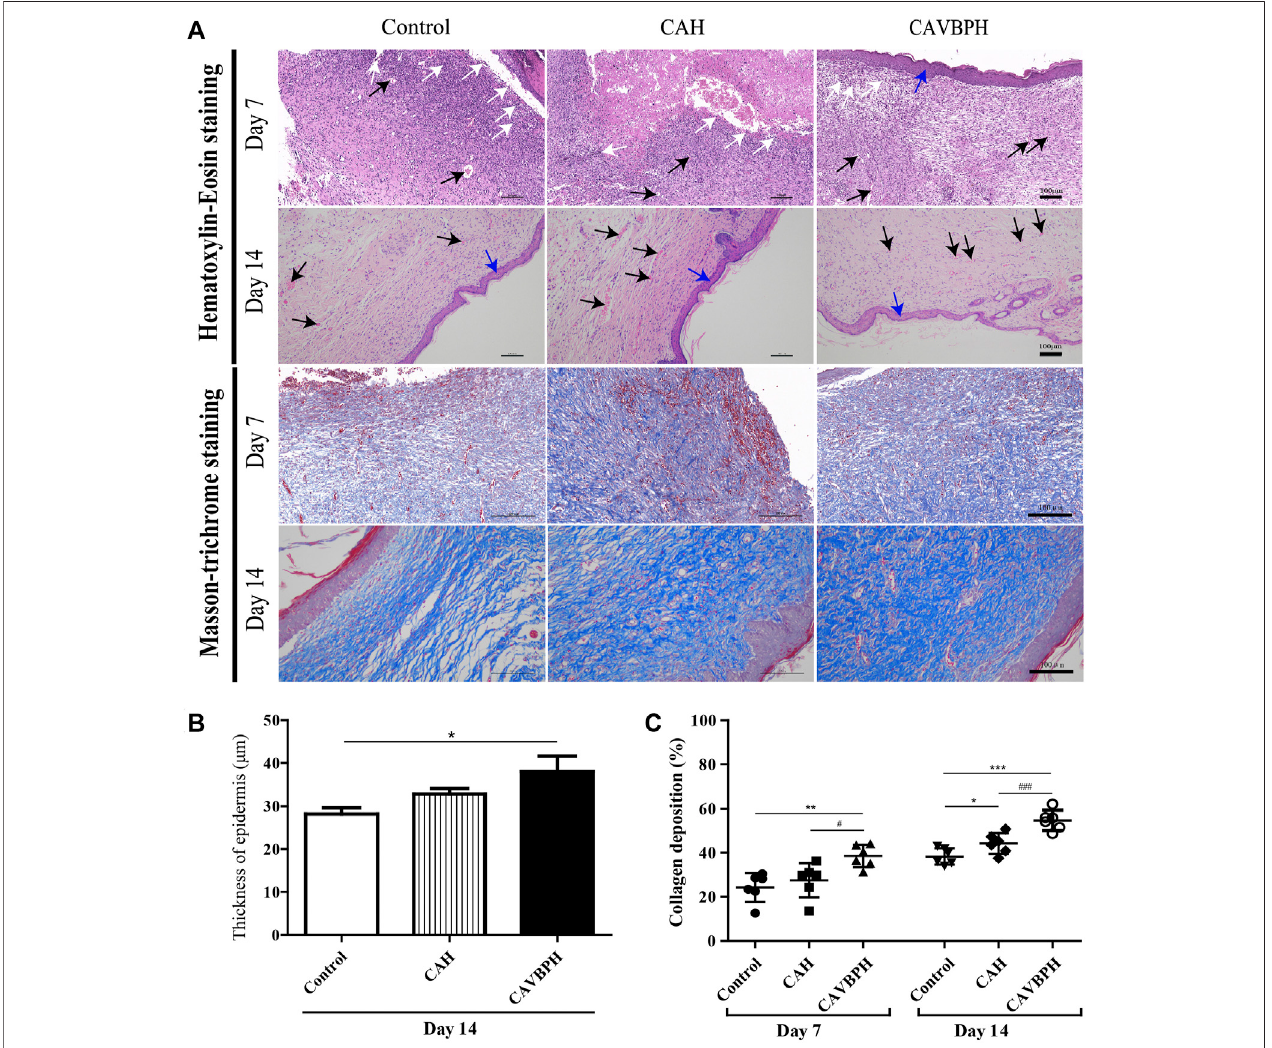
FIGURE 4 | Histopathological analysis of skin wounds in the control, CAH, and CAVBPH groups ’ mice on days 7 and 14. (A) H&E staining and Masson staining (scale bar = 100 μ m). White arrows indicate in fl ammatory cells, black arrows indicate capillary vessels, and blue arrows indicate new epithelial tissues, respectively. (B) The thickness of the epithelial tissue on day 14. (C) Collagen content of skin wounds on days 7 and 14. * p < 0.05, ** p < 0.01, *** p < 0.001 vs . control group; # p < 0.05, ## p < 0.01, ### p < 0.001 vs . CAH group as statistically signi fi cant.